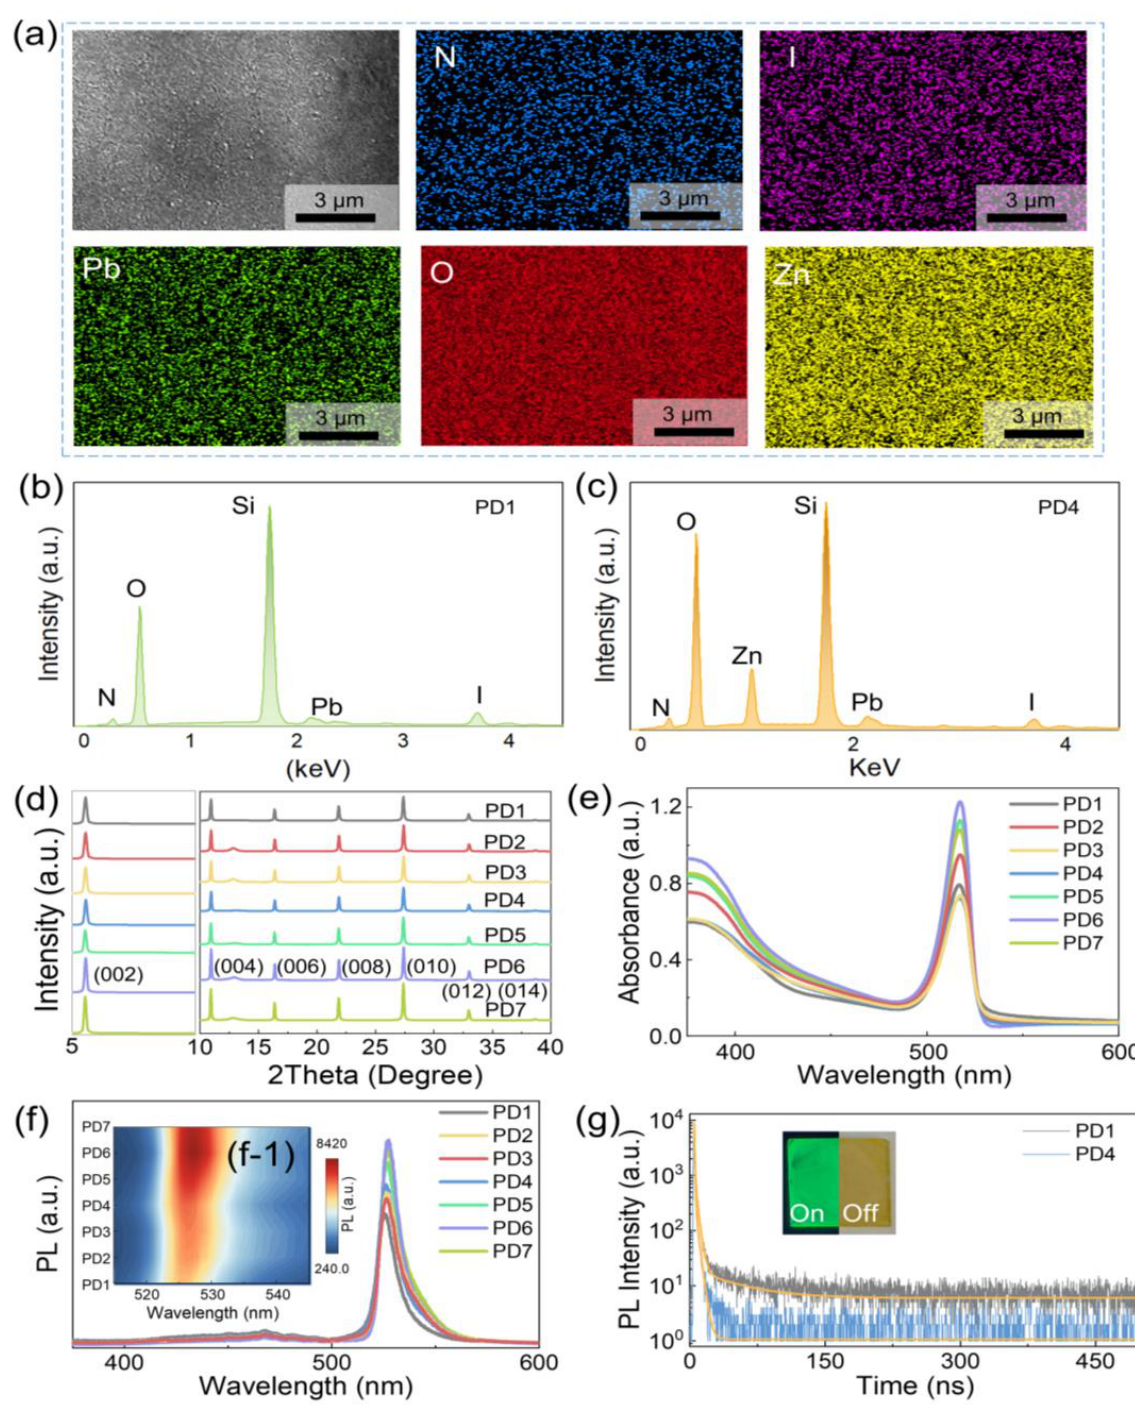
Figure 2. ( a ) Energy dispersive X-ray spectroscopy (EDS) element maps of the photodetector PD4. Energy dispersive X-ray spectroscopy (EDS) spectra of the photodetectors ( b ) PD1 and ( c ) PD4. ( d ) Corresponding X-ray diffraction (XRD) spectra. ( e ) Absorbance and ( f ) room-temperature PL spectra of the devices. ( f – 1 ) The contour maps of wavelength dependent PL for the devices. ( g ) Time- resolved photoluminescence (TRPL) spectra of the photodetectors PD1 and PD4. (Inset) The optical images of the sample under UV illumination (left) and white light (right).